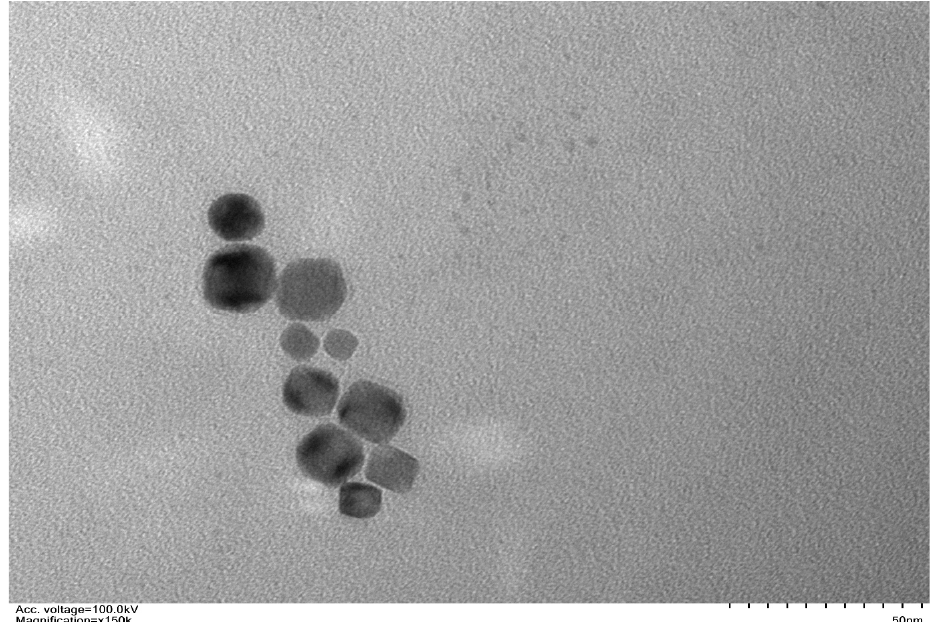
Figure 7. The transmission electron micrograph of the selenium particles showing spherical to quasi spherical shapes. For imaging purpose, a FEI Tecnai 12 apparatus fitted with a digital camera from Gatan was used. The particles were dried on a copper grid coated with a carbon layer. The primed seeds were germinated in fi ve separate seed trays corresponding to each priming treatment regime (i.e., tray one with 0 ppm treated seeds, trays 2, 3, 4, and 5 planted with seeds primed with 25, 50, 75, and 100 ppm concentrations of SeNPs. The seed trays were then placed in a growth chamber with fl uorescent lighting (140 mmol m − 2 ·S − 1 ), a photoperiod of 16/8 h (light/dark period), a temperature of 24/18 °C (day/night), and regular irrigation with tap water every two days. At the three-leaf stage, tomato plants were transferred to the fi eld for the drought experiment [77]. Two major plots (5 m × 3 m) were created in the experiment’s allo tt ed space, one for each irrigation scheme (i.e., water and water stress). Five (1 m × 3 m) subplots were then created for each main plot, containing plants, one for each distinct seed priming treatment (i.e., 0, 25, 50, 75, and 100 ppm). Three equal-sized rows made up the subplots, which are referred to as replicates. So, three plants (one plant from each row) were selected for dif- ferent analysis. There was no guardrail installed. Three rows of tomato plants were raised in each subplot of each major plot with a 45-cm intra- and 90-cm inter-row spacing, re- spectively [22]. In accordance with Dewis and Freitas [78], the soil’s physical and chemical properties were investigated. The soil used in the experiment had a clay loam texture, a 28.3% fi eld capacity, and a 14% permanent wilting point. The soil type was vertosol. The soil’s pH was 7.6, and its electrical conductivity was 1.48 dSm − 1 (1:5 H 2 O). It had 7.7 mg of organic carbon per gramme, 4.1 mg of extractable NO 3 -N, 1.1 mg of extractable NH 4 -N, and 116 mg kg − 1 of total P. Drought stress was imposed to the water stressed plot following de fi cit irrigation principle proposed by Capra et al., [79]. Throughout the duration of the trial (twelve weeks), the tomato plants received full water applications (2 inches of water a week) as part of the water treatment. Treatment for water stress includes giving the plants full wa- ter for the fi rst week, then withholding water for two weeks, carrying the same routine till the experiment lasted [79].